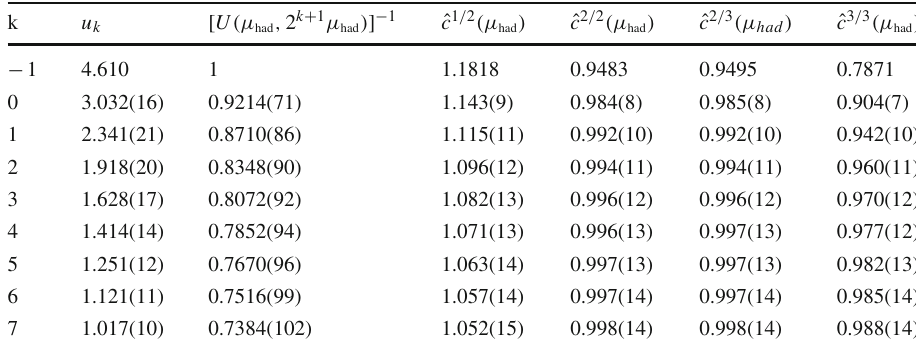
Table 18 Non-perturbative N f = 2 running in the scheme α = 1 / 2. (Our best result ˆ c 2 / 3 (μ ) is had